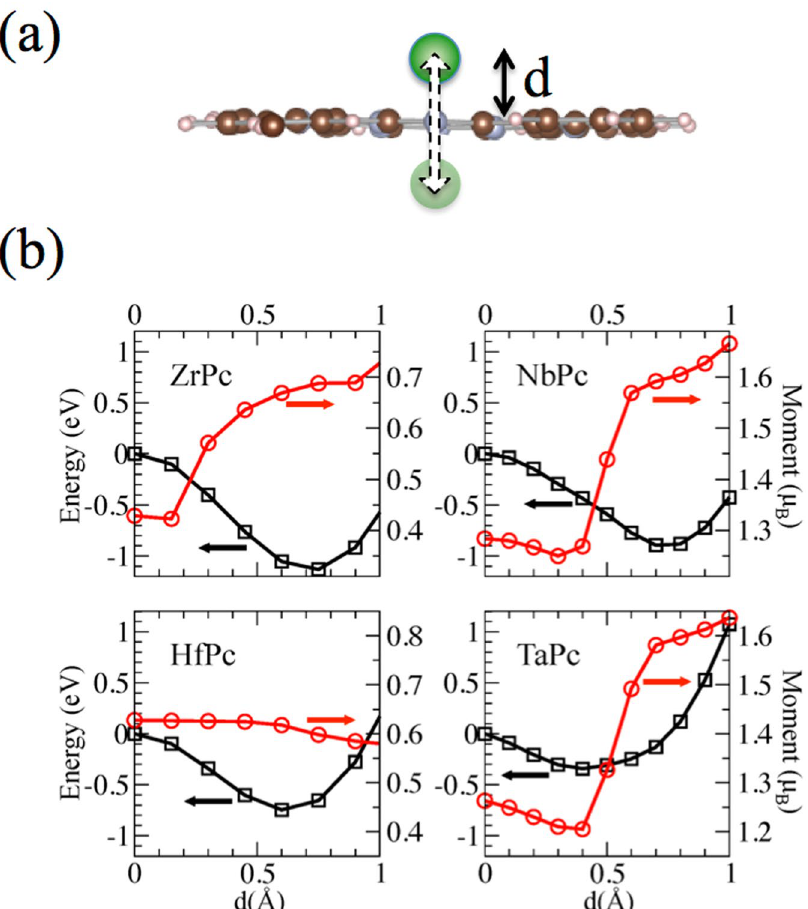
Figure 2. ( a ) Molecular structure used for the estimation of the energy barrier relative to the displacement of the metal ion from one side to the other of an isolated Pc macrocycle. The Pc macrocycle is flat and its atoms are held fixed. The metal ion is shifted rigidly along the molecule axis. ( b ) Energy profile (black square) for the transition described in ( a ) for ZrPc, NbPc, HfPc, and TaPc molecules. The red circles show the values of the magnetic moments of the metal ions (right